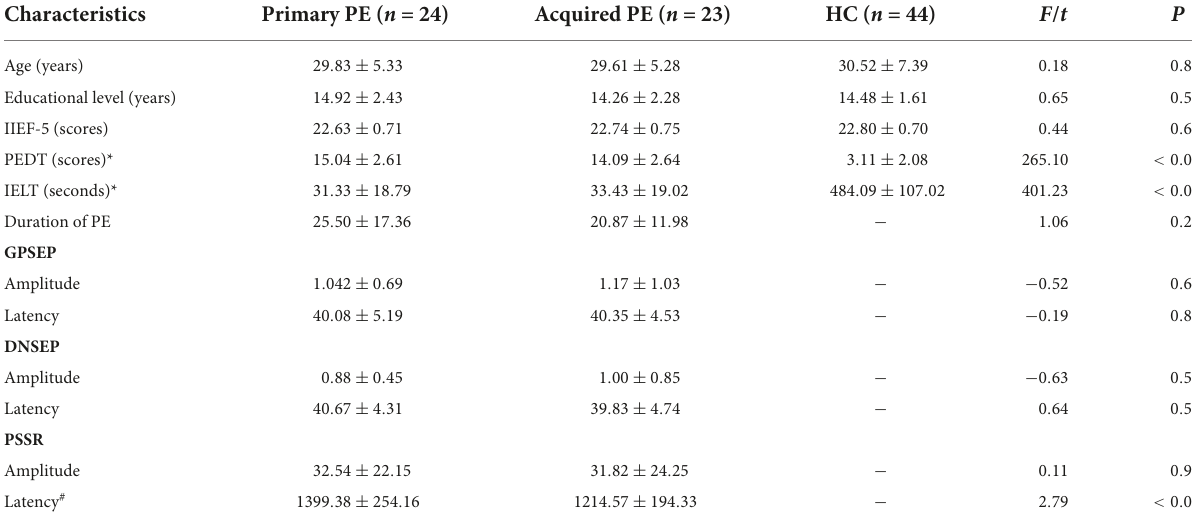
TABLE 1 Demographic and clinical characteristics of participants.